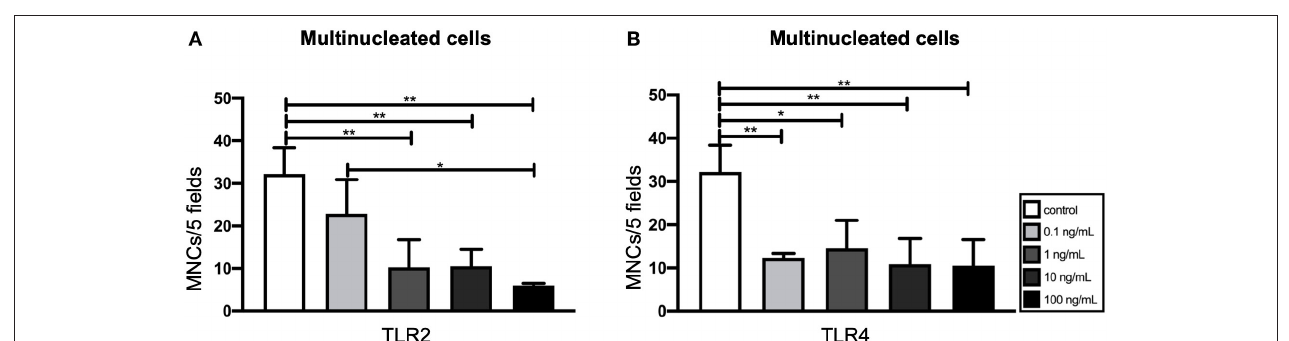
FIGURE 1 | Effect of Toll-like receptor (TLR) agonist concentrations on the osteoclastogenic and the osteogenic capacity of gingival fibroblasts (GF). (A) The number of multinucleated cells formed in the presence of TLR2 agonist (0.1–100ng/ml). (B) The number of multinucleated cells formed in the presence of TLR4 agonist (0.1–100ng/mL). Titration experiments were performed using three different GF donors in duplicates, average results ± SD are shown. Significant results for (A) and (B) are shown (black bars). * p < 0.05, ** p < 0.01.